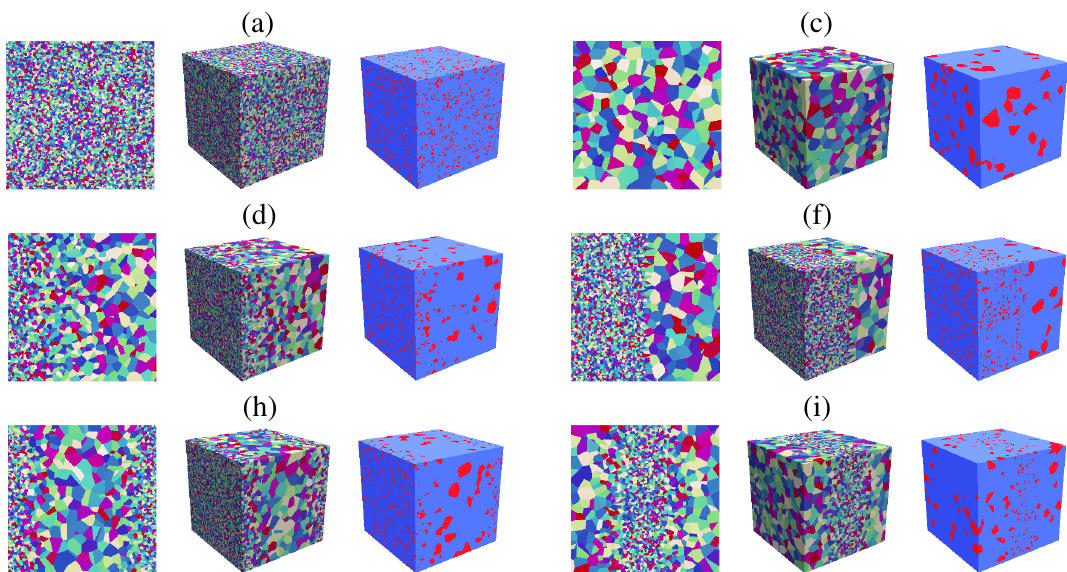
Figure 1: Examples of realizations of heterogeneous Poisson-Voronoi tessellations with a gradient structure along the x -axis, in a box of side L = 10 , obtained with different laws τ ( x ) chosen by using Eq. (2) for calibration and the following laws (see main text for an explanation): constant chord length (a and c), linear gradient (d), step-wise variation (f), sine-like gradient (h and i). For each law, we show the plane section Oxy of the tessellation at z = 0 before the coloring procedure (left), the three-dimensional visualization before the coloring procedure (middle) and the three-dimensional visualization after the coloring = 0 . 1 of assigning a red label procedure with probability p α